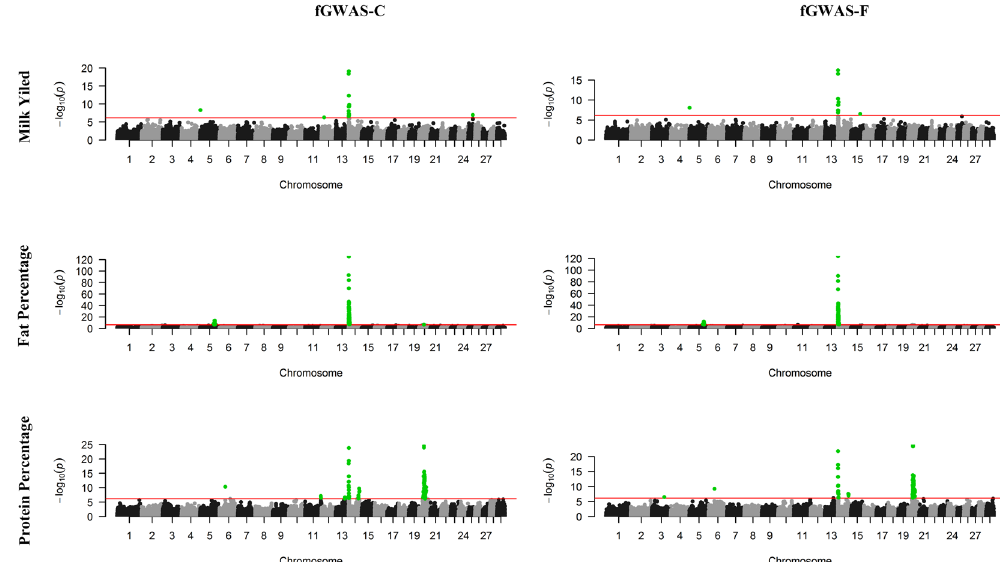
Figure 5. Manhattan plots of p -values for milk yield (MY), fat percentage (FP), and protein percentage (PP) by the fGWAS-C and fGWAS-F model for the Chinese Holstein cattle data. Chromosomes 1–29 were shown with black and grey intervals. The red horizontal lines indicated the genome-wise significance level of − log 10 (6.98 × 10 − 7 ) and SNPs above the lines were highlighted in